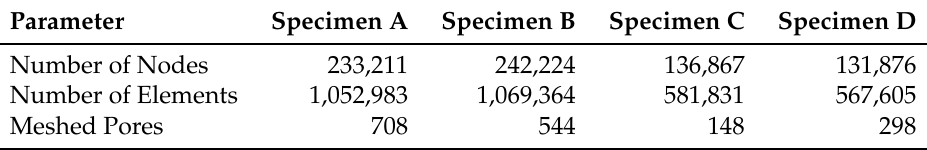
Table 3. Properties of the created FE-Meshes.